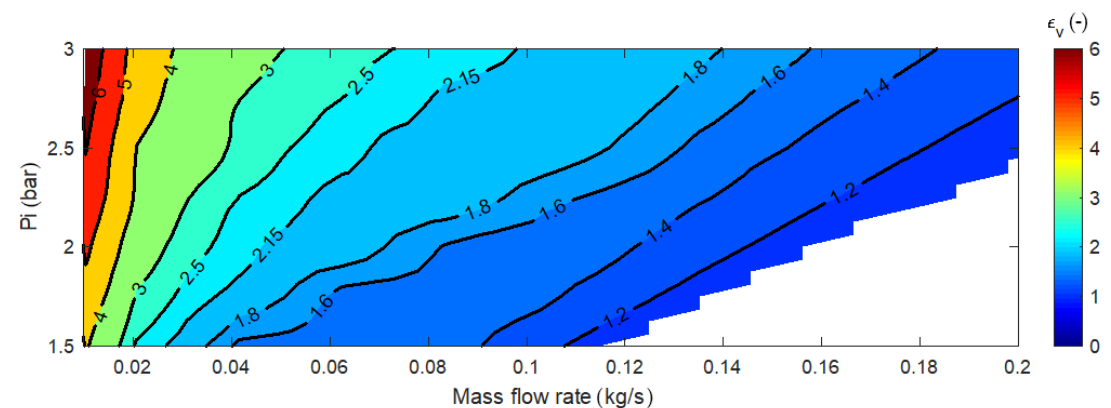
Figure12. Built-involumeratio( (cid:15) v )correspondingtomaximumisentropice ffi ciencyofGL51twin-screw Figure 12. Built-in volume ratio ( (cid:2035) (cid:3049) ) corresponding to maximum isentropic efficiency of GL51 twin- expander running on air (Ti = 75 ◦ C and Po = 1 screw expander running on air (Ti = 75 °C and Po = 1 bar).